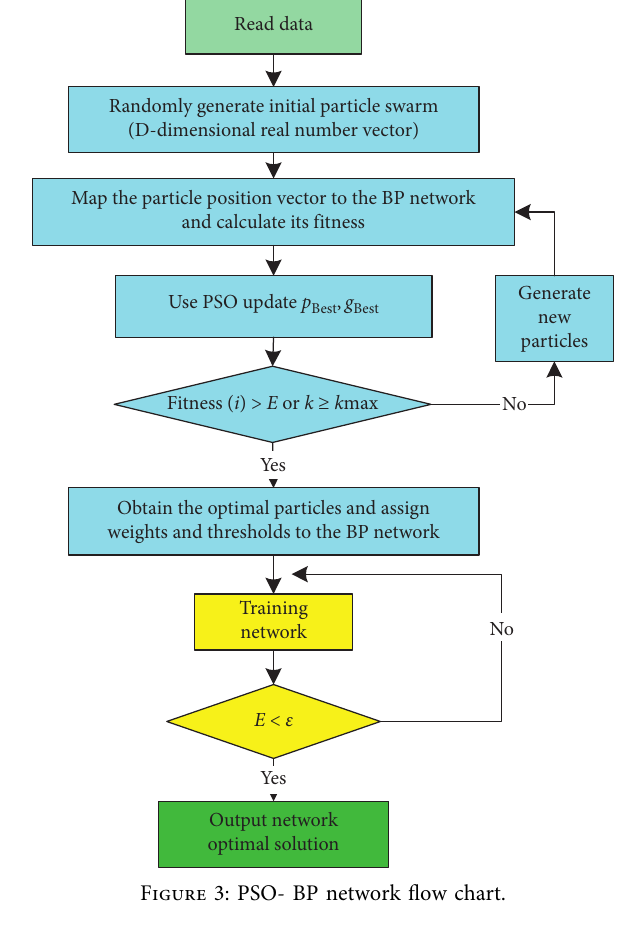
Figure 3: PSO- BP network flow chart.